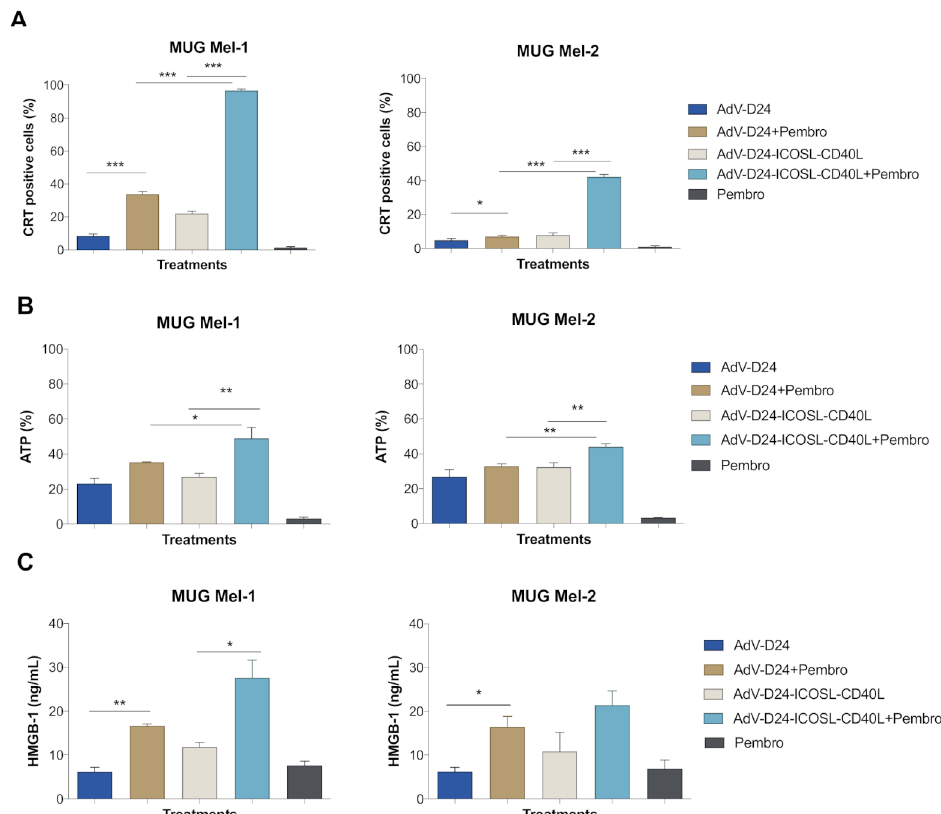
Figure 4. Immunogenic cell death assessment. ( A ) Evaluation of calreticulin (CRT) exposure by melanoma cell lines after treatment with oncolytic adenoviruses AdV-24-ICOSL-CD40L and AdV-D24, and in combination with anti PD-1. CRT exposure was measured 48 h post-treatments with anti- calreticulin antibody staining AlexaFluor ® 488 and subsequent flow cytometry analysis (Beckman- Coulter Cytomics FC500). ( B ) Assessment of ATP release after the treatment. ATP concentration in a supernatant was evaluated 72 h after infection with CellTiter-Glo ® Luminescent Cell Viability Assay ATP detection kit by Promega. ( C ) Evaluation of high-mobility group box 1 (HMGB-1) release after treatment with oncolytic adenoviruses and the combination with anti PD-1. HMGB-1 level